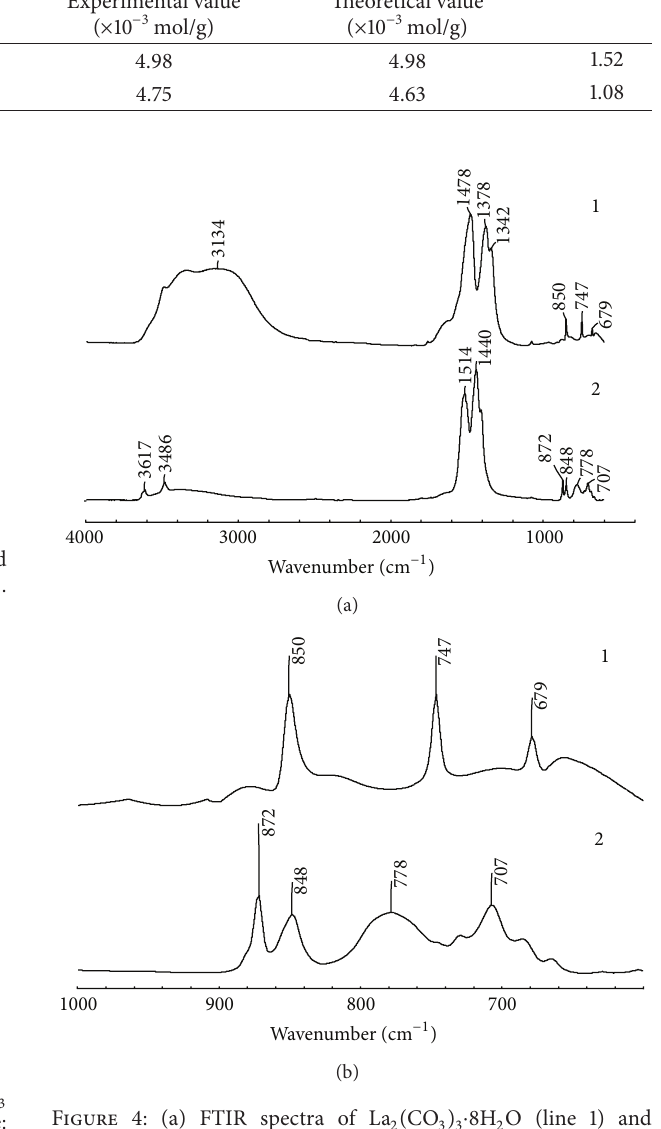
observed in the fingerprint region (1000 ∼ 600 cm −1